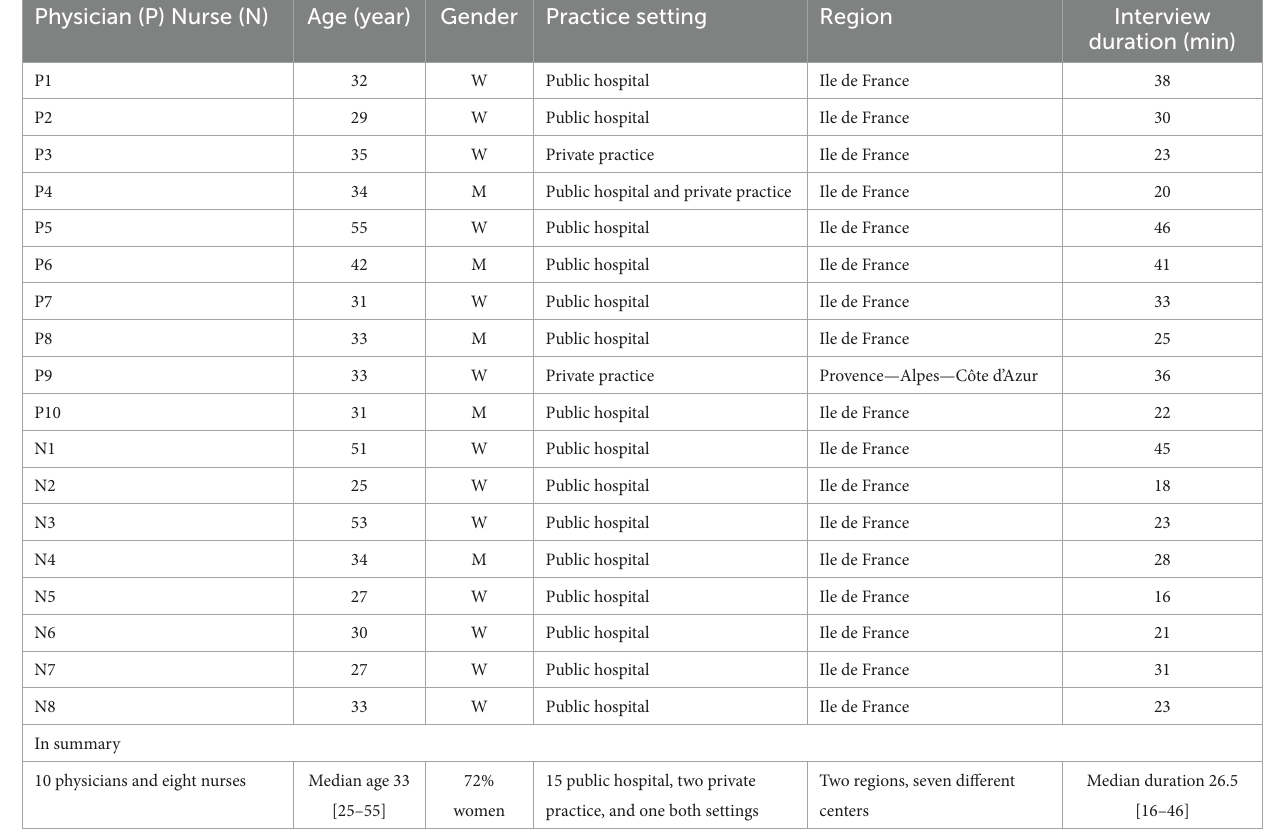
TABLE 1 Vascular medicine physicians and nurses participating in the